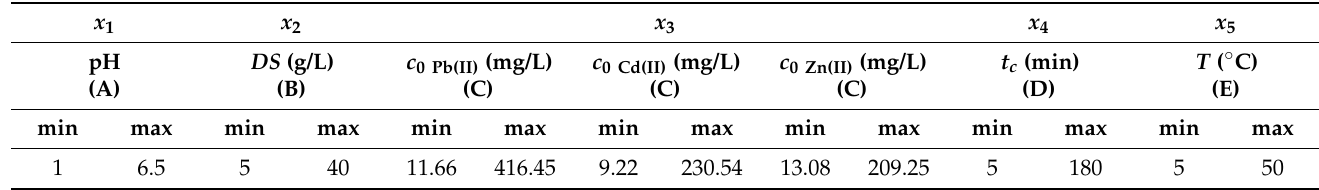
Table 7. Independent variables of the biosorption process and variation